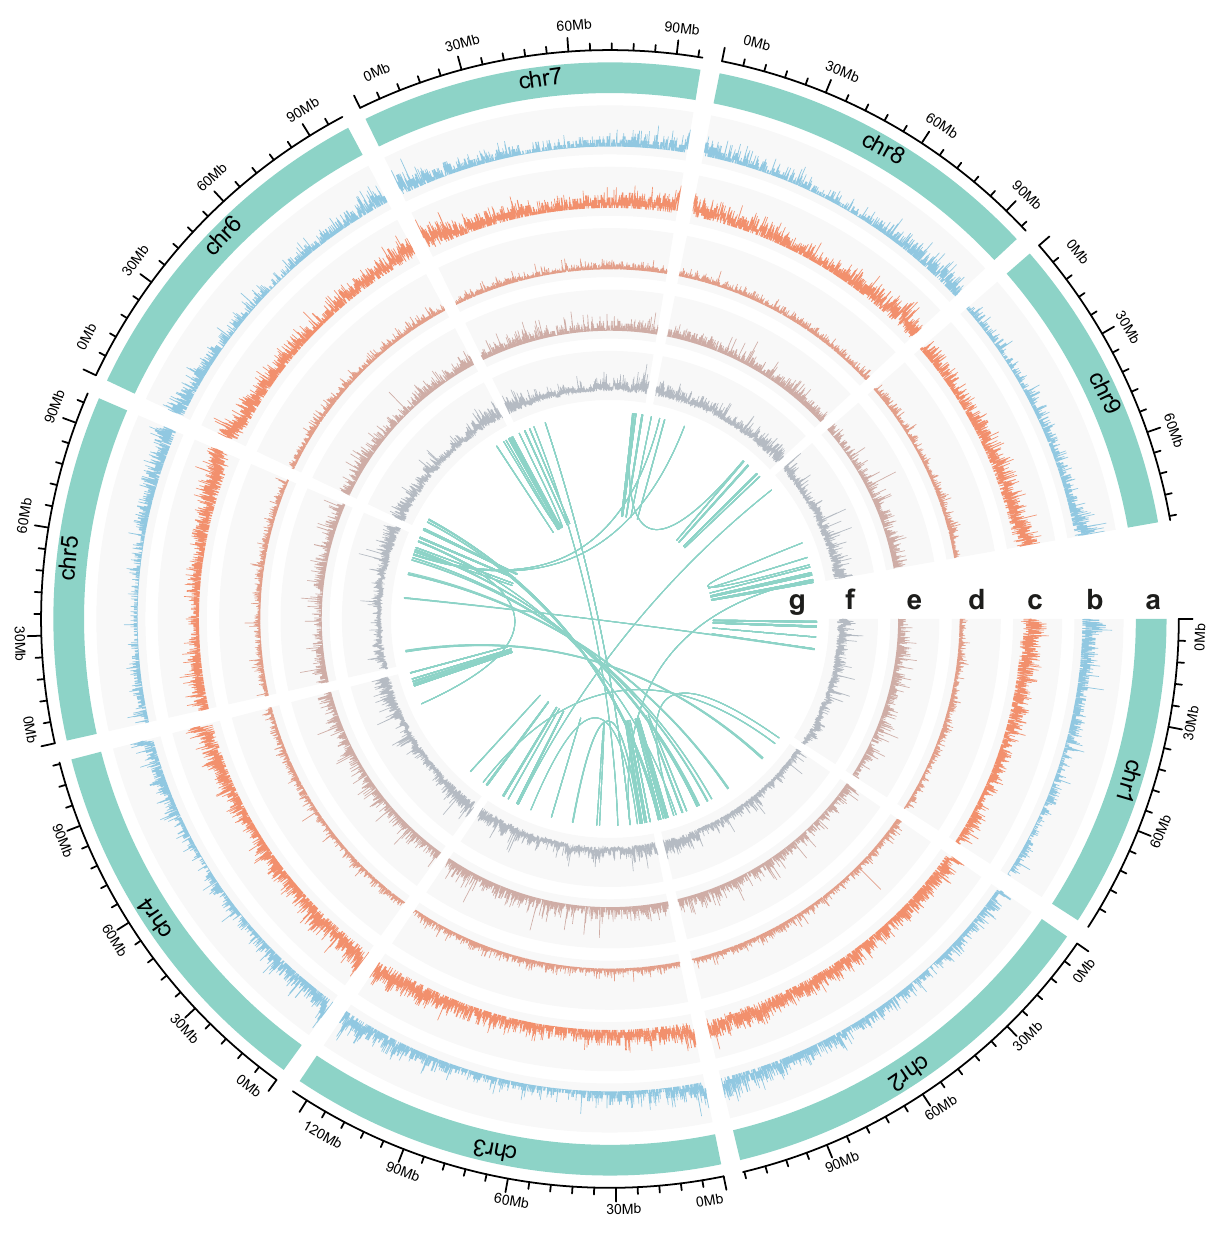
Fig. 1 Landscape of genome assembly and annotation of Coptis chinensis . a Chromosome-scale pseudomolecules (chr1 – chr7). b Density of transcripts. c Gene density. d Density of long retrotransposon terminal repeats. e Density of DNA transposable elements. f Density of biallelic heterozygous single- nucleotide polymorphisms. g Intragenomic synteny